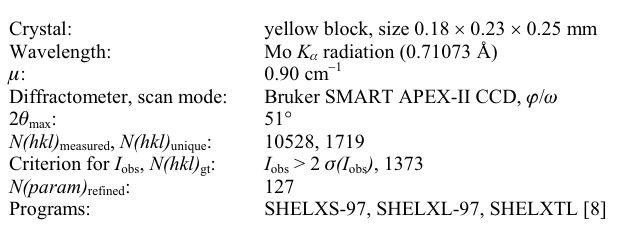
Table 1. Data collection and handling.